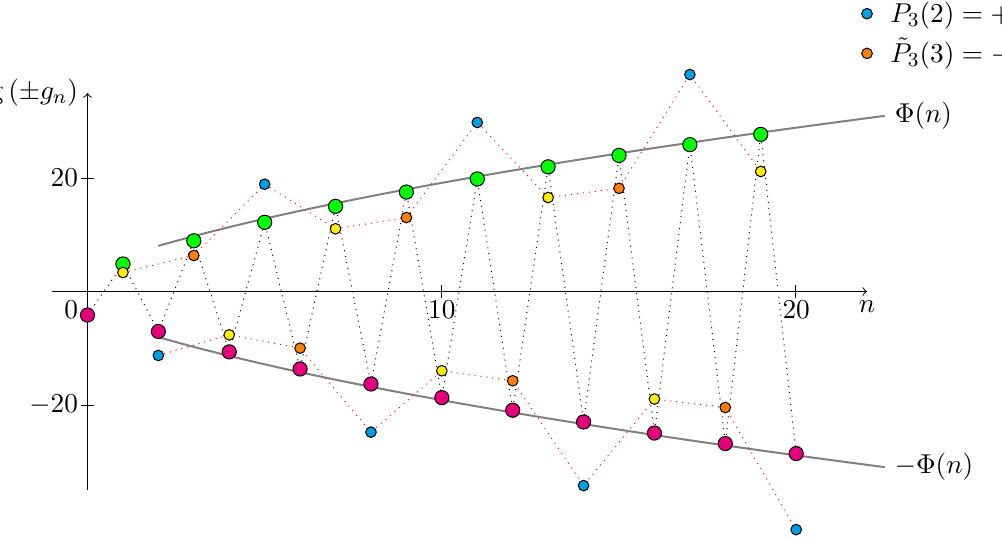
Figure 7 . A schematic plot representing the spectrum of an anti-D p -brane on top of an O p -plane, including the terms at leading order, for α = 1 , and the (magnified) corrections at next-to-leading order, for α = 3 . One has to consider bosons (odd n ) and fermions (even n ) separately, since the corrections to the coefficients of the partition function M ( τ ) are computed with the dual function ˜ ˜ M ( τ ) . Then, levels n = 1 mod 3 have corrections multiplied by the value P 3 (1) = − 1 , levels ˜ n = 2 mod 3 have corrections multiplied by the value P 3 (2) = +2 and levels n = 3 mod 3 have corrections multiplied by the value ˜ P (3) = − 1 . For each different value the function ˜ P ( n ) can take, 3 α one can individuate a different interpolating function. Evidently, the average of such interpolating functions vanishes, independently from each other, both in the bosonic and in the fermionic